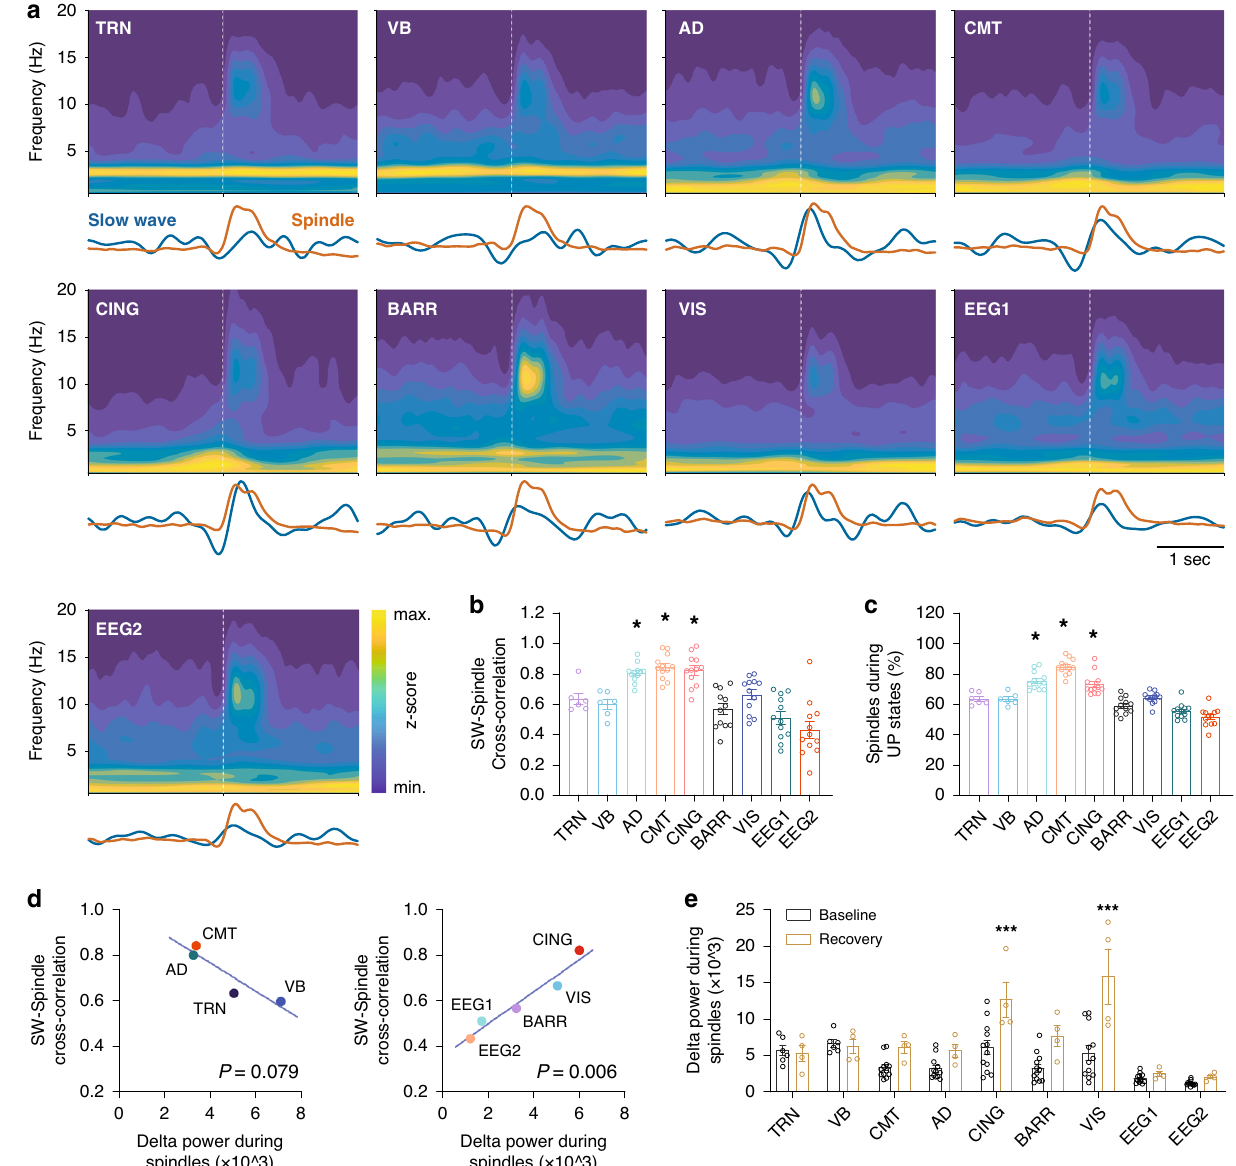
Delta power during (×10^3)Delta power during spindles spindles (×10^3) Fig. 3 Spindles coincide with slow waves (SW) within the CMT, CING, and AD. a Graphs show the average time – frequency representations of spindles. Vertical dotted white lines indicate the onset of spindles. Traces below the spectrograms show average of fi ltered LFPs for SW (blue, 0.5 – 4 Hz) and average of envelope of fi ltered LFPs in the spindle range (red, 9 – 16 Hz). Representative time – frequency graphs and traces were obtained from 334 ± 19 thalamic and 318 ± 39 cortical spindles. b Normalized cross-correlation between SW and spindle envelope indicates a signi fi cant SW – spindle coupling within the CMT, CING, and AD as compared to other sites (CMT, CING, and AD vs. others: P < 0.05; F = 19.2; d.f. = 8; one-way ANOVA with Tukey ’ s post- hoc test, * P < 0.05; n = 6 animals for TRN/VB, n = 12 for other sites). c Percentage of spindles that coincide with UP states. The CMT, AD, and CING have signi fi cantly higher ratios of spindles occurred during UP states as compared to the other sites (CMT, CING, and AD vs. others: P < 0.01; F = 40.2; d.f. = 8; one-way ANOVA with Tukey ’ s post-hoc test, * P < 0.05; n = 6 animals for TRN/VB, n = 12 for other sites). d Correlation between delta power during spindles and SW – spindle coupling for the thalamic and cortical sites. This correlation is weak for the thalamic nuclei, while signi fi cantly high for the cortical sites ( P = 0.079 for thalamic nuclei; P = 0.006 for cortical sites; two-tailed Pearson ’ s correlation test; n = 6 animals for TRN/VB, n = 12 for other sites). e Delta power during spindles signi fi cantly increases for cortical, but not for thalamic, LFP recordings during recovery sleep (yellow) as compared to baseline (black; recovery vs. baseline: P <0.001 for CING and VIS; P <0.05 for BARR; F = 17.5; d.f. = 8; two-way ANOVA with Sidak ’ s post-hoc test, *** P <0.001; baseline: n = 6 animals for TRN/VB, n = 12 for other sites; recovery: n = 4 animals). Bars indicate mean±SEM. Source data are provided as a Source Data fi